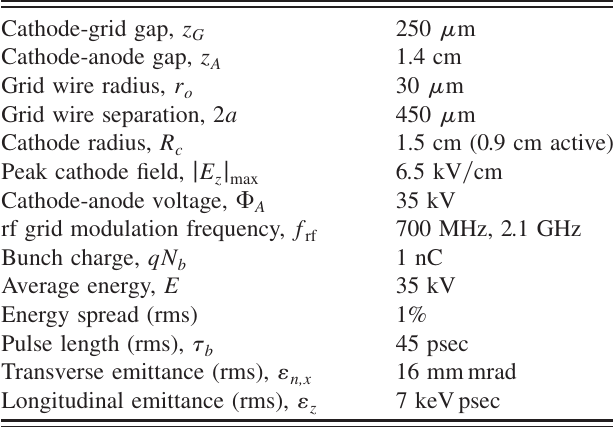
TABLE II. Parameters used for PARMELA simulation of an rf- gated, gridded thermionic gun for a high-average-power FEL. The gun geometry is shown in Fig. 19. Bunch diagnostics are provided at the gun exit at z ¼ 5 : 0 .